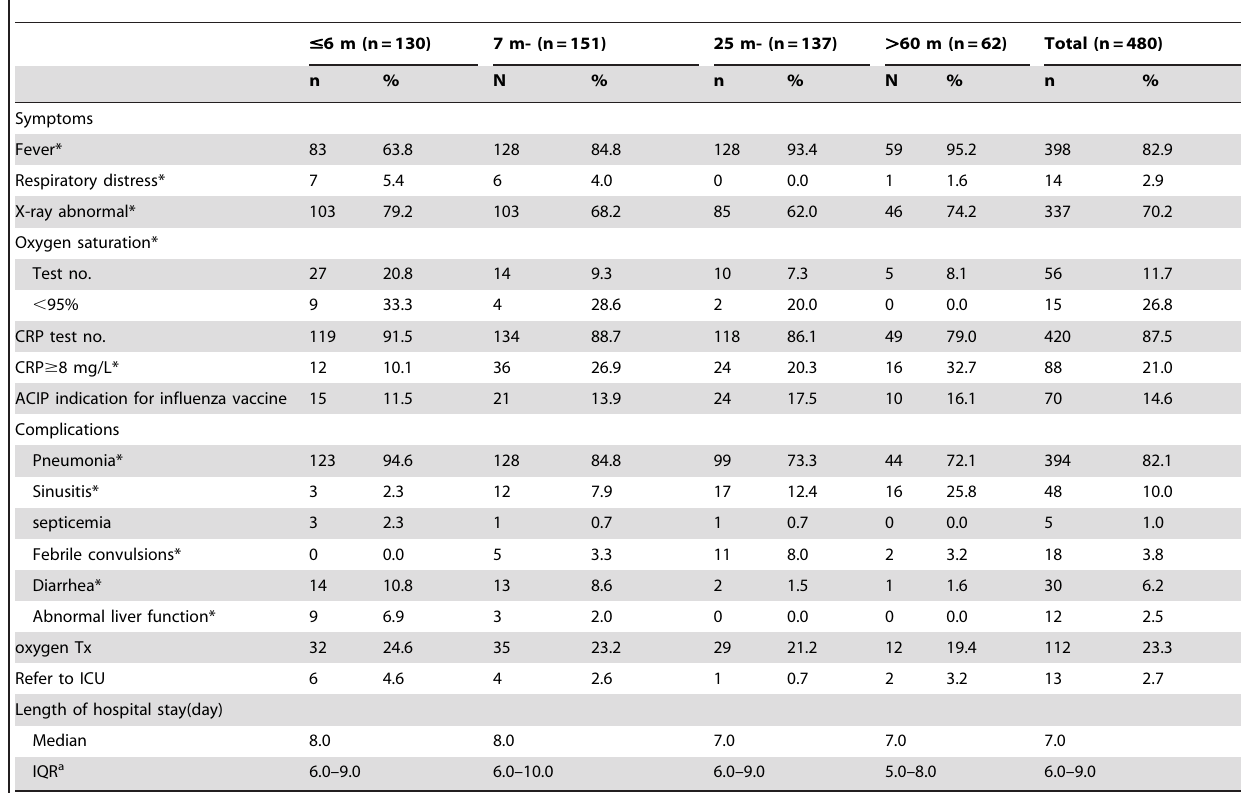
Table 2. Clinical characteristics by age group of the influenza positive children hospitalized in Suzhou Children Hospital from 2005 to